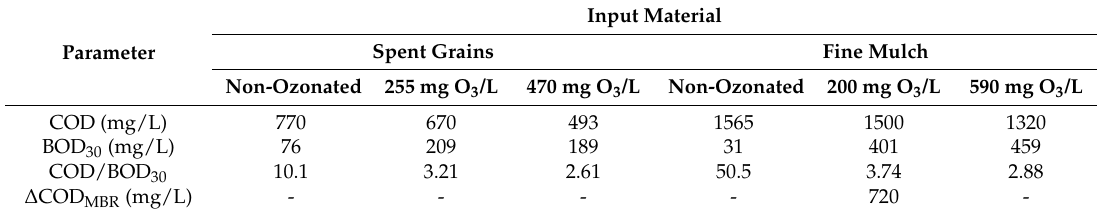
Table 7. Effect of ozonation on the aerobic degradability of pre-treated spent grains and fine mulch